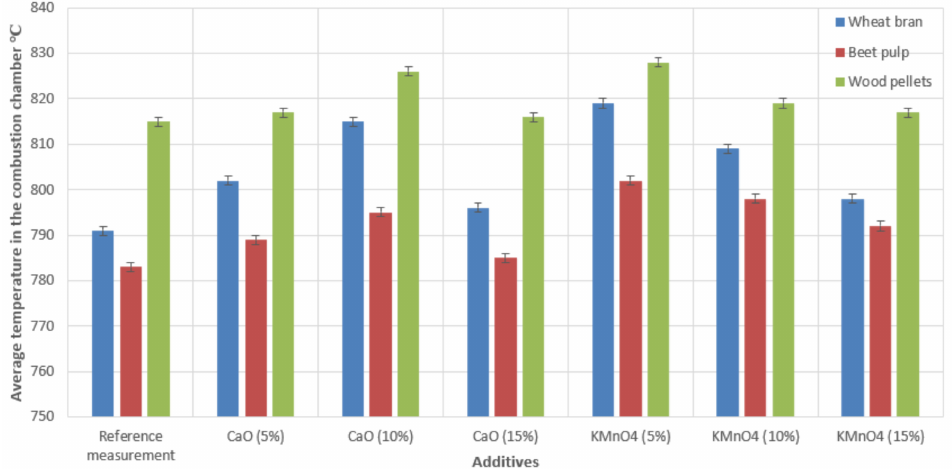
Figure 7. The distribution of the average temperatures in the combustion chamber during the combustion of biomass with catalytic